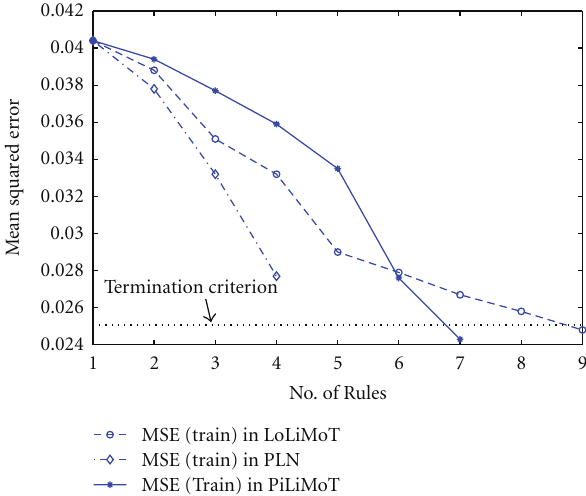
Figure 6: Neurons centers for original LoLiMoT, PLN, and new combined learning algorithm.